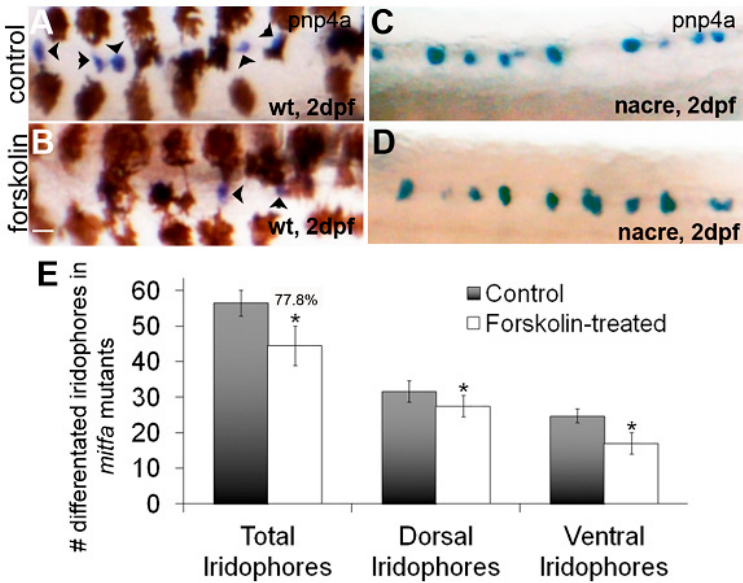
Figure 5. A subset of mitfa negative iridoblasts is resistant to PKA signaling. ( A – D ) Brightfield images of dorsal trunks of wildtype or nacre/mitfa mutant larvae at 2 dpf treated with 0.1% DMSO or 5 µM forskolin and processed for in situ hybridization using a pnp4a probe. A reduction in pnp4a is detected in wildtype (as previously observed) but not in nacre/mitfa larvae. Scale bar = 100 um and applies to all images. ( E ) Quantification of differentiated iridophores in 0.1% DMSO or 5 µ M forskolin-treated nacre/mitfa larvae. We note a significant, yet attenuated reduction in iridophores with mitfa loss of function (22.2% reduction in iridophores or 77.8% of control). The reductions are significant via Student’s t -test ( p <